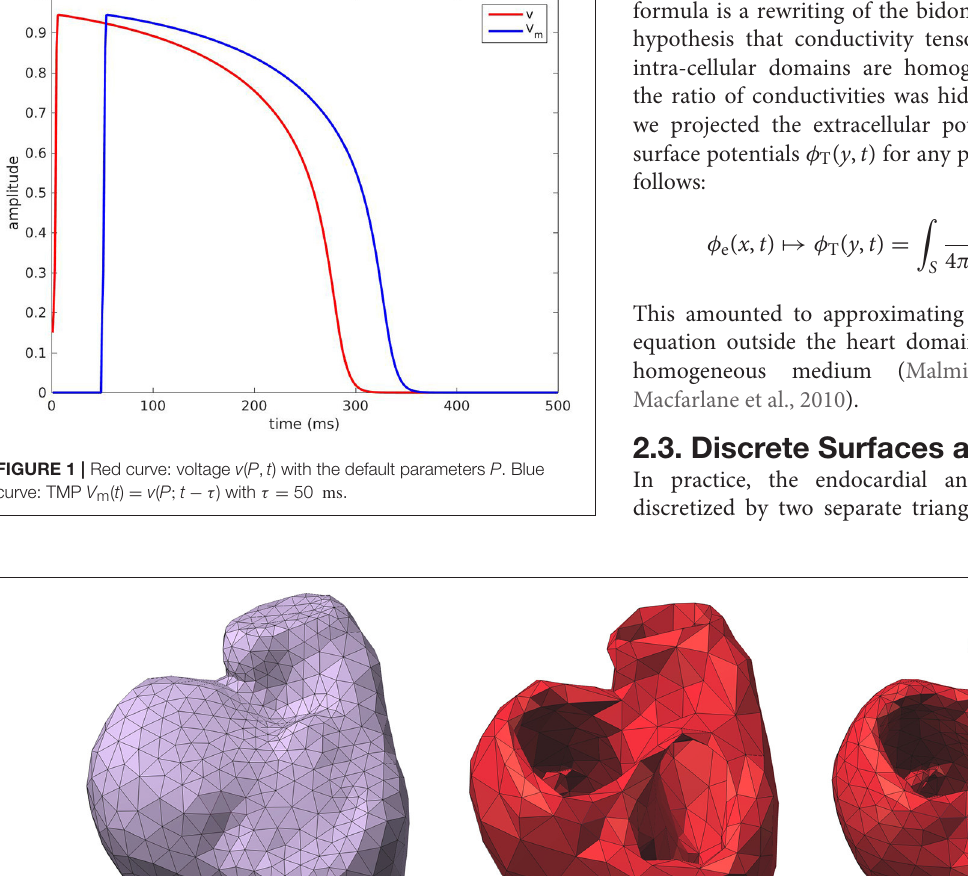
Frontiers in Physiology |